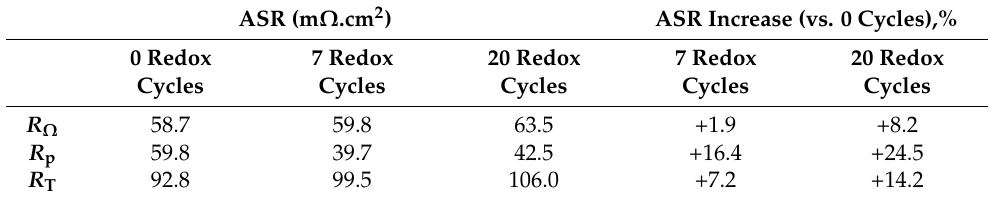
Table 3. ASR (ohmic R Ω , polarization R p and total R T ) of button cell after the initial reduction, after the 7th and 20th redox cycles. ASR (m Ω .cm 2 ) ASR Increase (vs. 0 Cycles),% 0 Redox 7 Redox 20 Redox 7 Redox 20 Redox Cycles Cycles Cycles Cycles R Ω